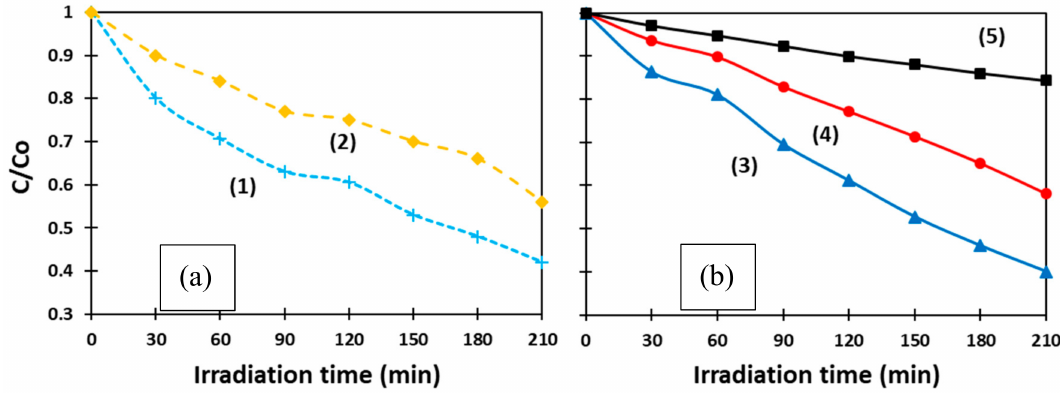
Figure 6. Photodegradation curves of methylene blue (MB) ( a ) in the presence of as-prepared ms-ZnO (1) and ns-ZnO (2); ( b ) in the presence of annealed ms-ZnO (3) and ns-ZnO (4). Curve (5) represents the blank